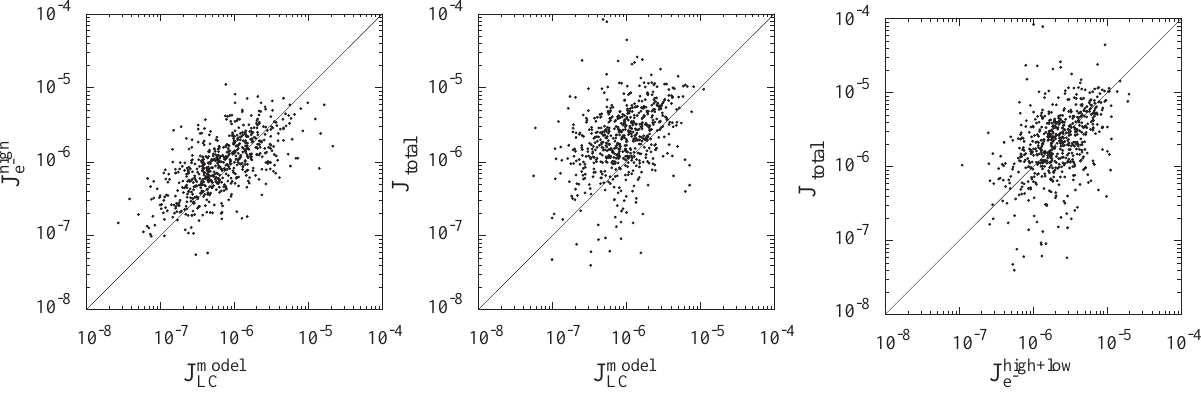
Fig. 7. Comparison of the field-aligned currents obtained during December 1989 to February 1990. Comparison between J high + high J model (left), J tot and J model (middle), and J tot and J low (right) are shown, LC B LC B e −